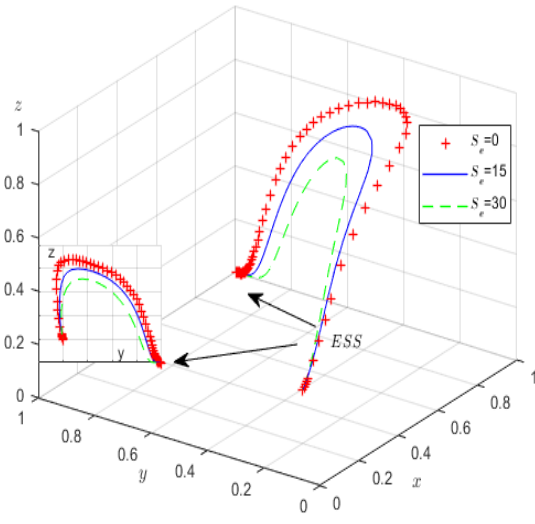
Figure 11. The influence of S e on evolutionary processes.